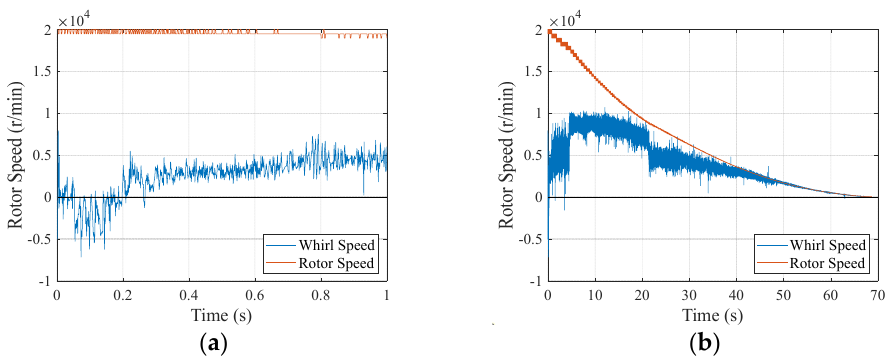
Figure 13. Rotor speed and whirl speed measured in the 20,000 r/min drop test: ( a ) First second, ( b ) Whole process.